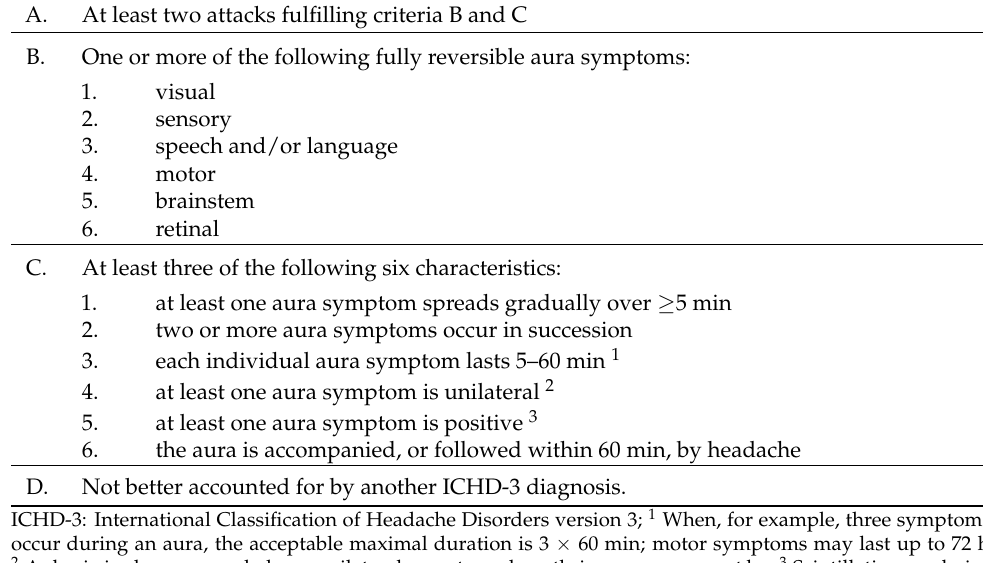
Table 1. ICHD-3 criteria for migraine with